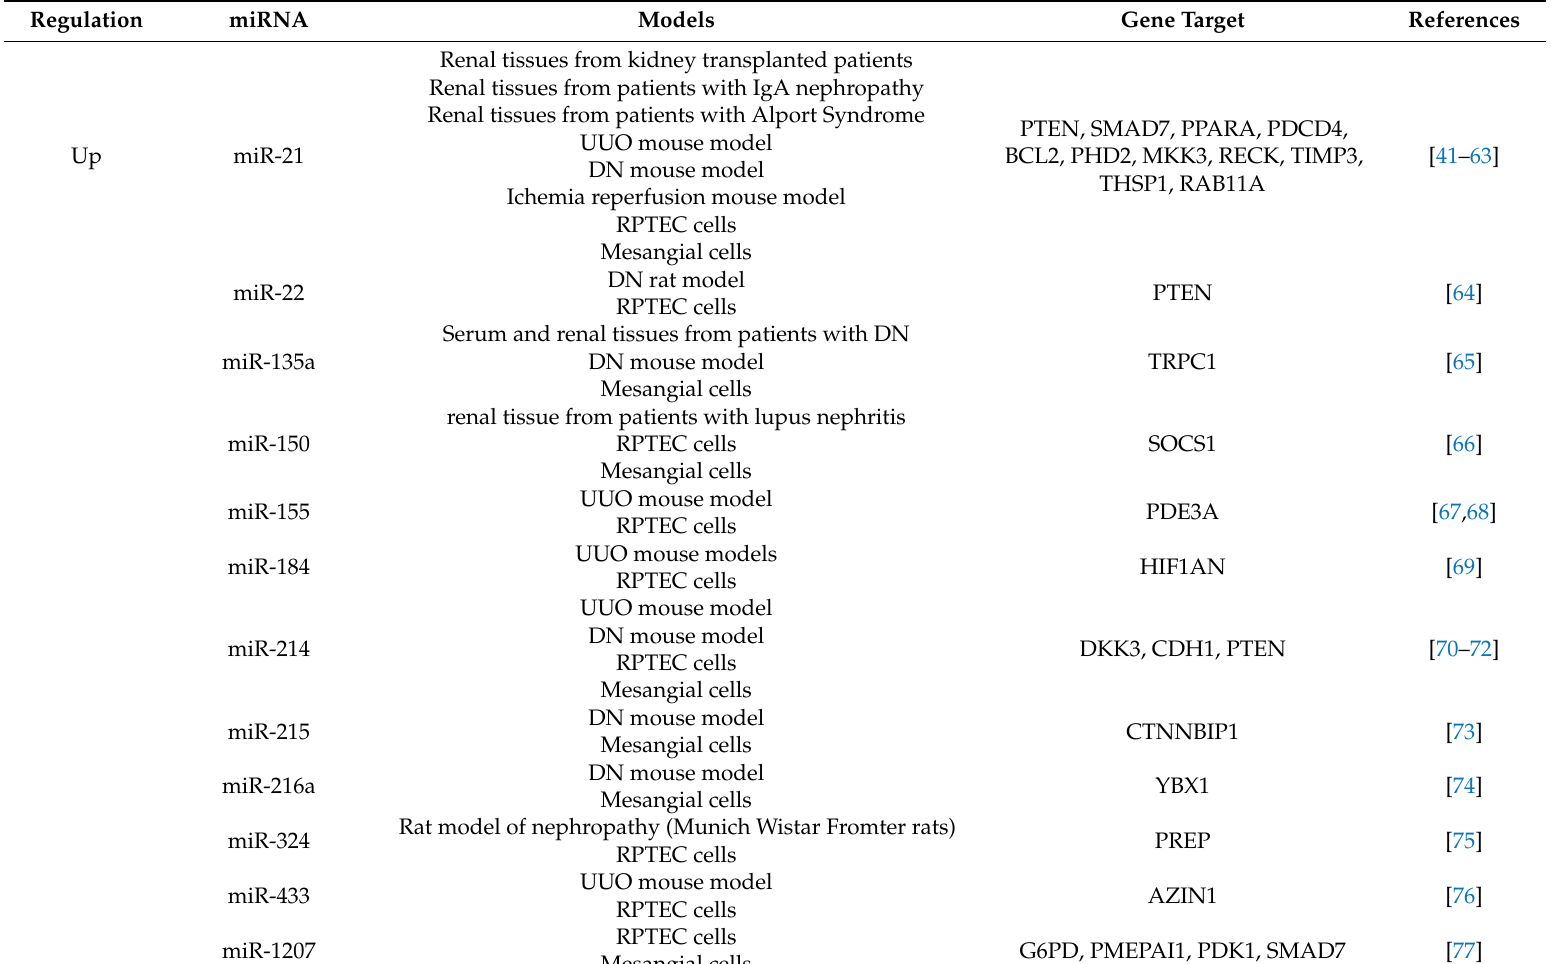
Table 1. Summary of miRNAs involved in renal